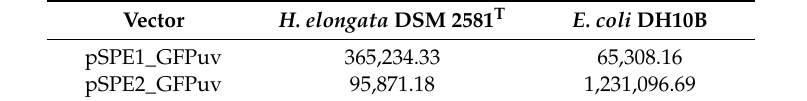
Table 3. Comparison of predicted translation initiation rates (a.u.) calculated with the RBS Calculator v2.0. The calculation is based on the respective gene ( gfpuv ) and the last nine nucleotides of the annotated 16S rRNA of the respective organism.